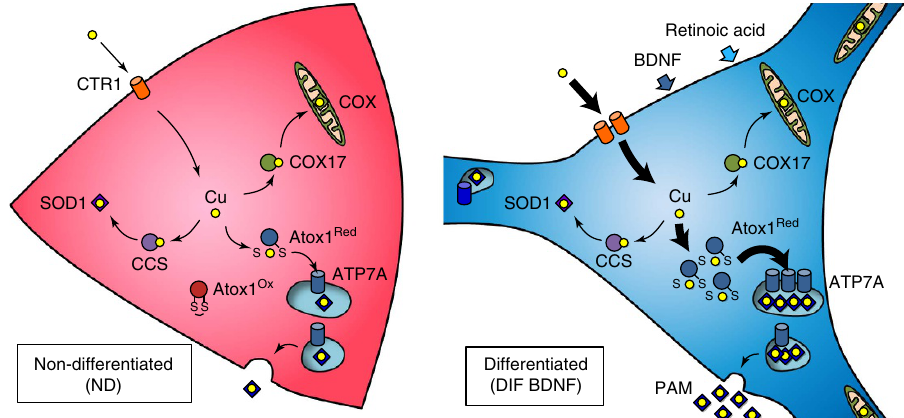
Figure 6 | Redox-regulated remodelling of cellular copper fluxes during neural differentiation of SH-SY5Y cells. The intracellular routes of copper (yellow circle) are indicated by arrows. Bold arrows represent the pathways upregulated upon